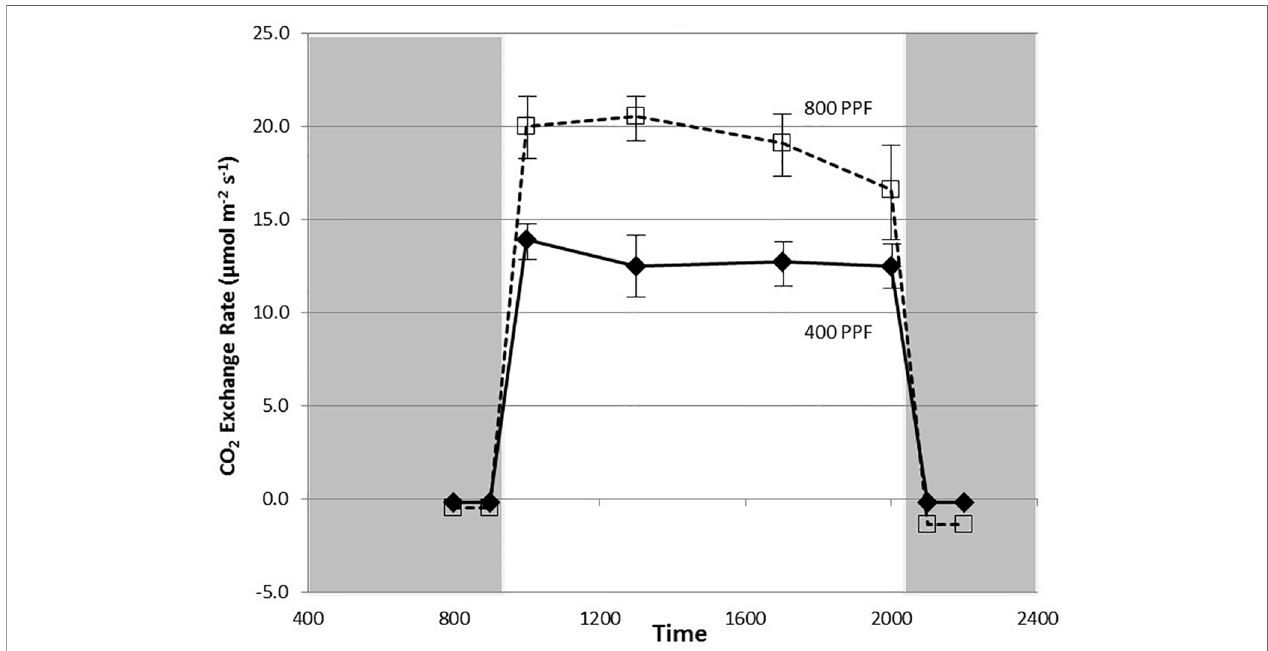
FIGURE 2 | Diurnal plot of net CO 2 exchange rates for young, fully expanded potato leaves of cv. Denali grown under a 12-h light and 12-h dark photoperiod at 350 ppm [CO 2 ]. Plants were grown at either 400 or 800 µmol m − 2 s − 1 photosynthetic photon fl ux (PPF). Each point represents n = 12 measurements from separate leaves, with standard deviation bars indicated. Positive values of CO 2 exchange in the light represent net photosynthesis and negative values in the dark represent